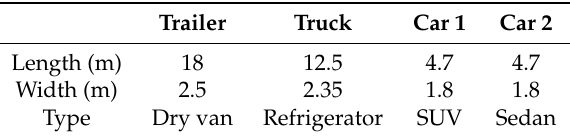
Table 1. Body sizes of vehicles.